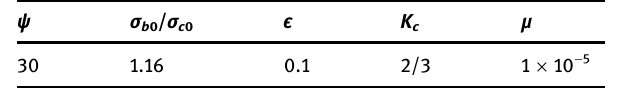
Table 3: De fi nition of plastic